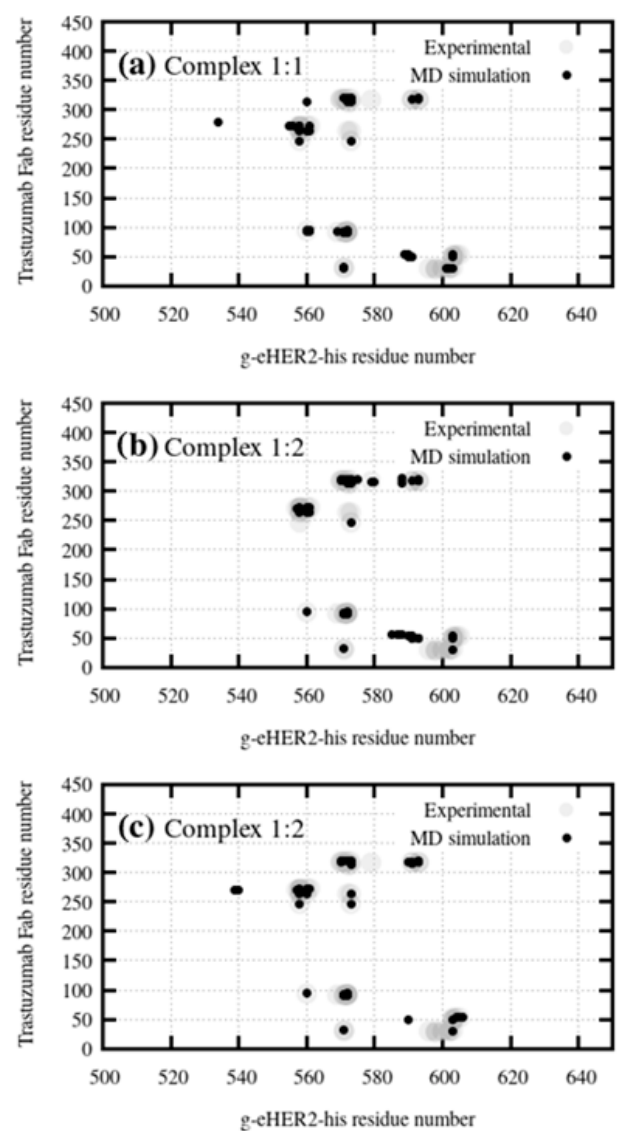
Figure 4. Residue contact maps corresponding to: ( a ) the simulated complex 1:1 and ( b ) and ( c ) correspond to the interaction between each g-eHER2-his molecule in the 1:2 complex and the corresponding Fabs in the TMZ compared to the crystallographic data (PDB code:1N8Z). The contact maps were calculated using the MDcons software [49]. Only contacts with a presence larger than 90% in the MD trajectory are shown.